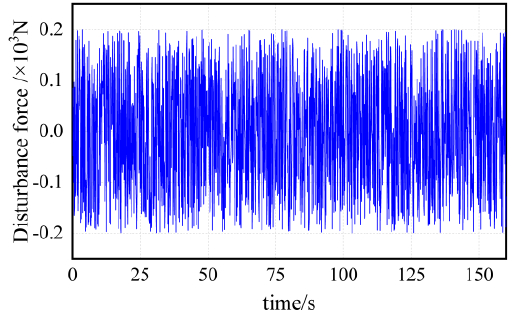
Figure 9. Transverse disturbing force.